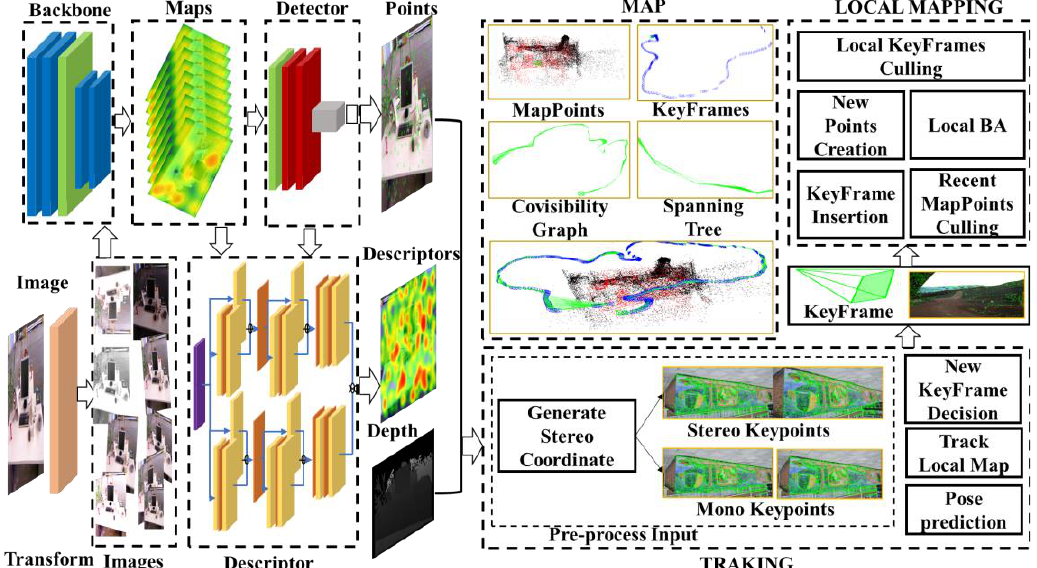
Figure 2. The overall framework of the proposed SLAM system. On the left, the feature detection and description frame architecture mainly includes three modules: backbone, feature detector, and descriptor. The right side is mainly composed of three parts: tracking, local mapping, and mapping.